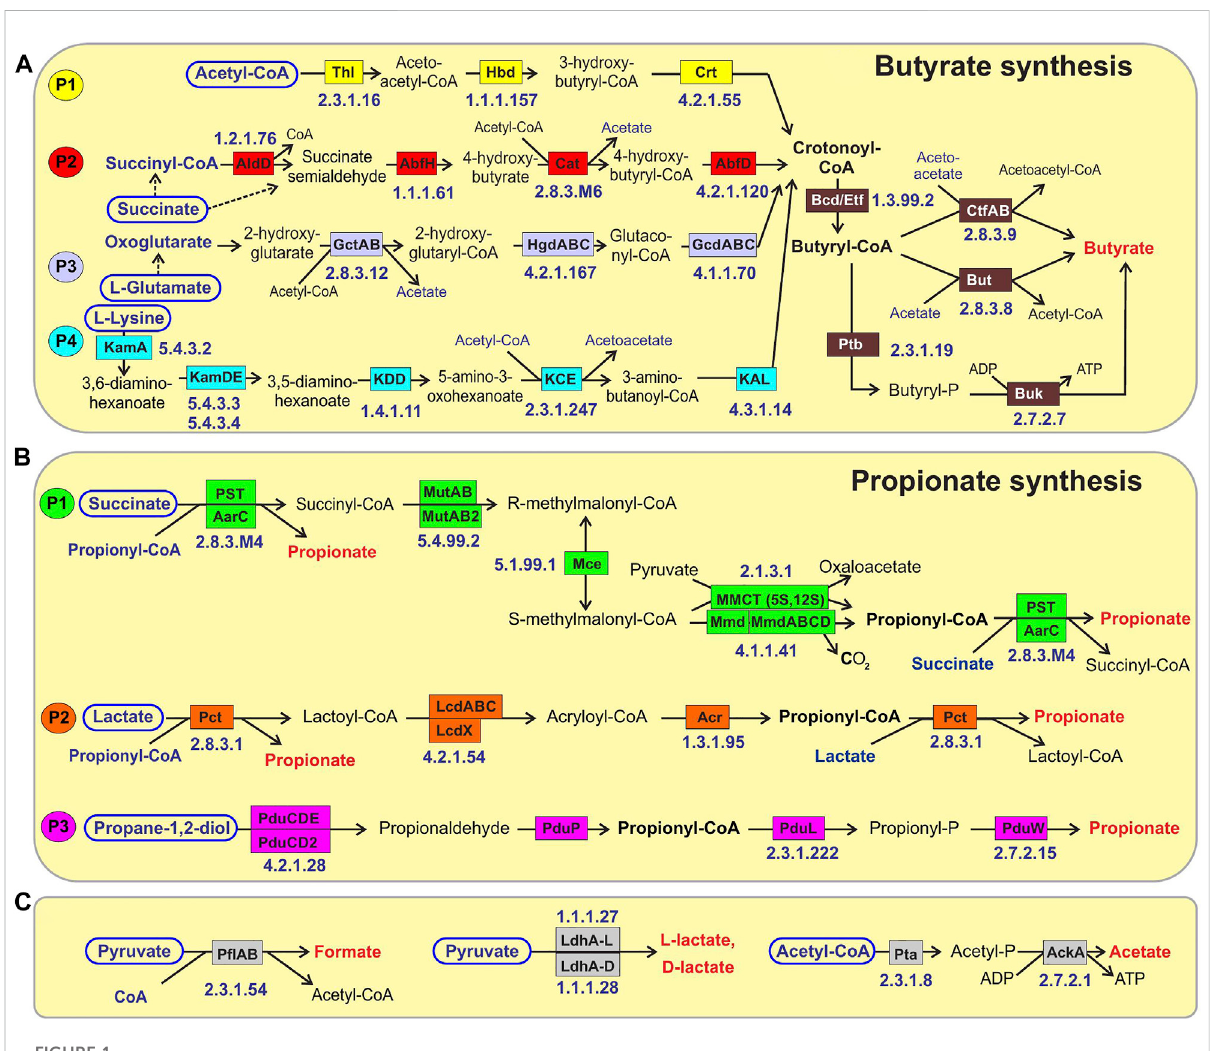
FIGURE 1 Reconstructed metabolicpathwaysof SCFA synthesis in referenceHGM genomes. (A) Butyrate synthesis, (B) Propionate synthesis, (C) Acetate, Formate and Lactate synthesis. Enzymes are shown by colored boxes with indicated Enzyme Commission (EC) numbers with detailed functional roles described in Supplementary Table S1. Alternative biochemical pathways for butyrate and propionate synthesis are highlighted by different colors. Shared biochemical routes for conversion of crotonoyl-CoA to butyrate are in dark brown boxes. Central carbon metabolism metabolites and amino acids serving as substrates for acid fermentation pathways are circled; fi nal fermentation products are in